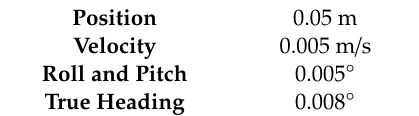
Table 2. Absolute Accuracy Specifications (RMS) + of the Inertial Measurement Unit (IMU)